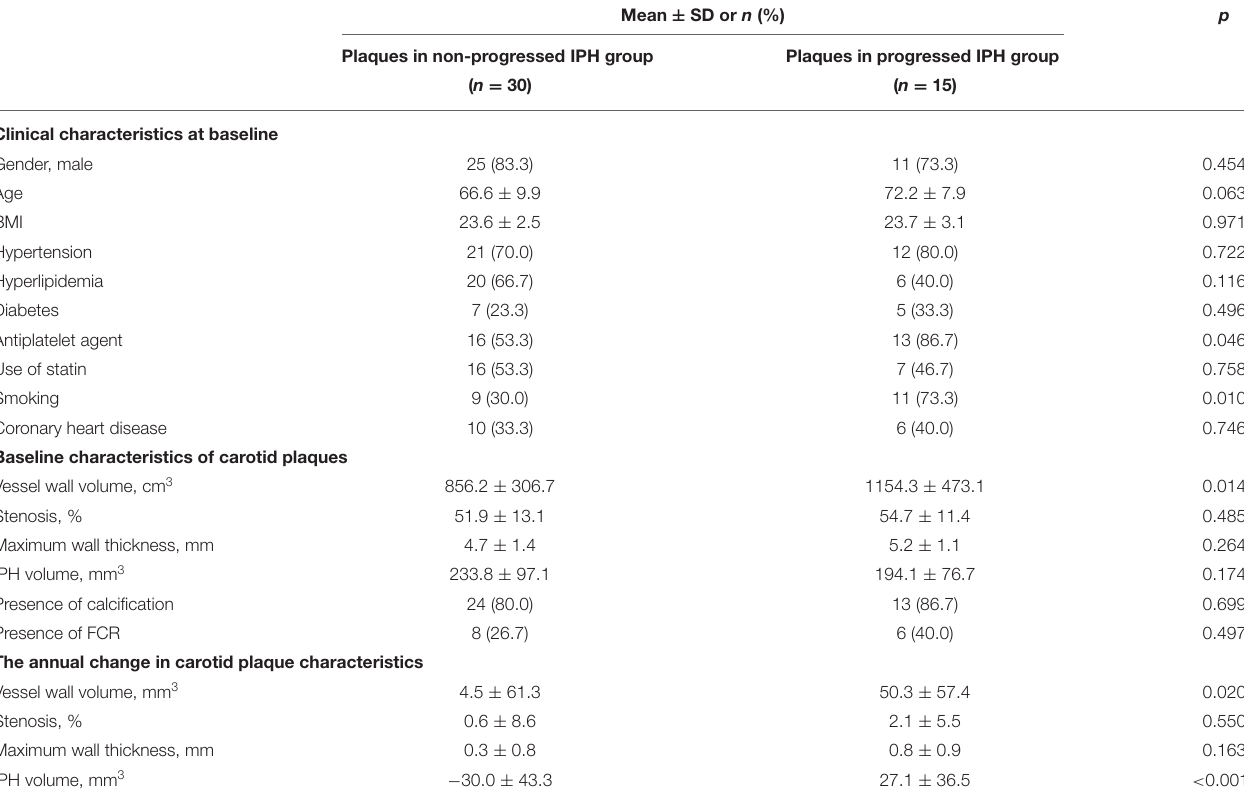
TABLE 2 | Comparison of clinical and morphological characteristics between plaques in the progressed and non-progressed IPH groups. Mean ± SD or n (%) p Plaques in non-progressed IPH group Plaques in progressed IPH group ( n = 30) ( n = 15) Clinical characteristics at